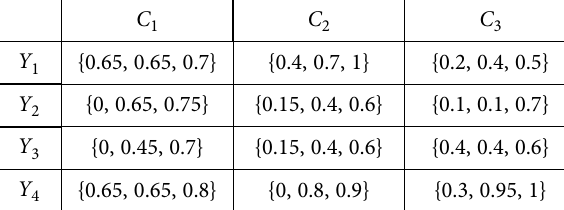
Table 6. Hesitant fuzzy decision